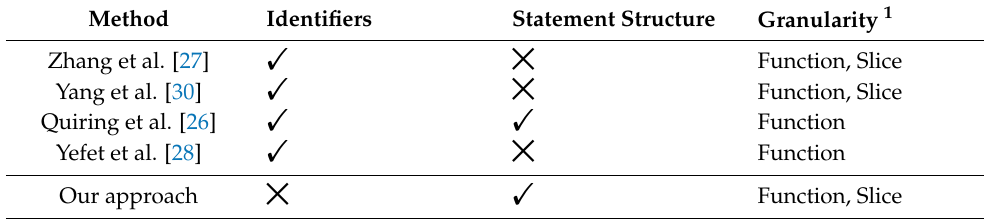
Table 8. Comparison of adversarial example generation